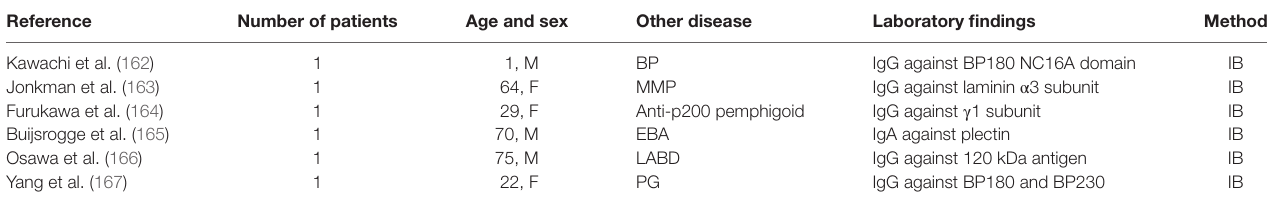
TABLe 3 | EBA associated with other autoimmune bullous disease.